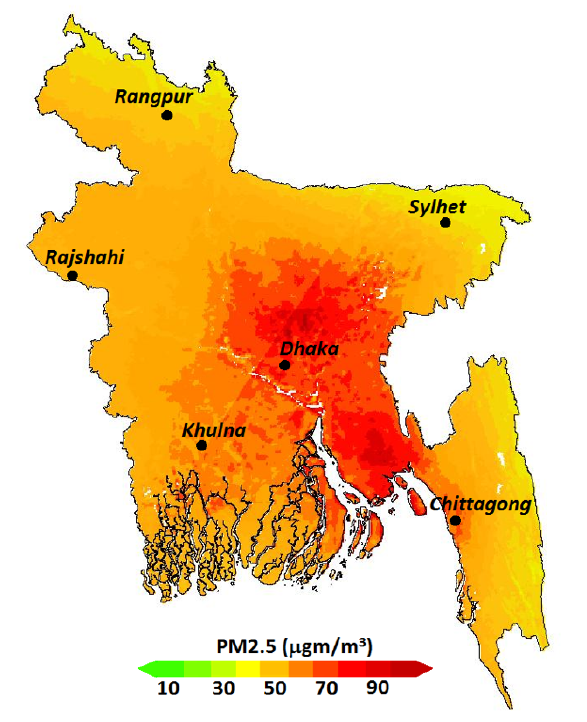
Figure 1 . Spatial distribution of PM 2.5 in Bangladesh, averaged over